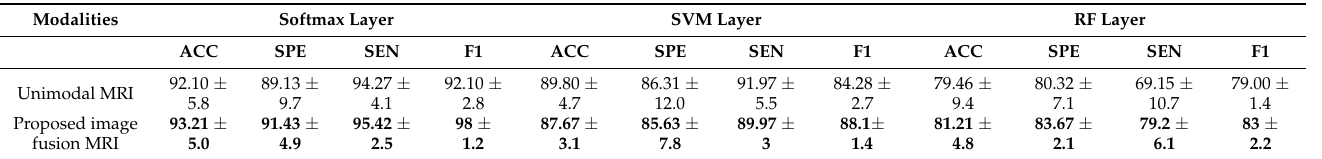
Table 4. Results of the proposed image fusion method against a single modality based on 3D-CNN in three different epoch